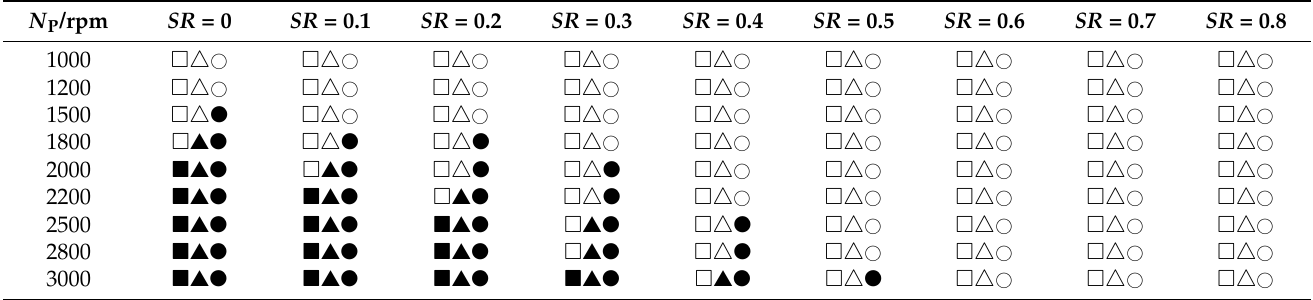
Table 2. The occurrence of cavitation inside the torque converter under various N P and SR . N P /rpm SR = 0 SR = 0.1 SR = 0.2